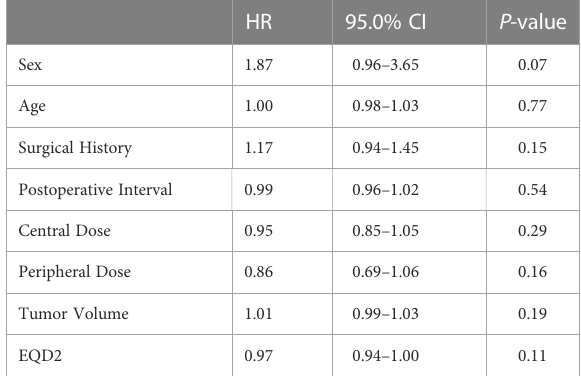
TABLE 2 Univariate